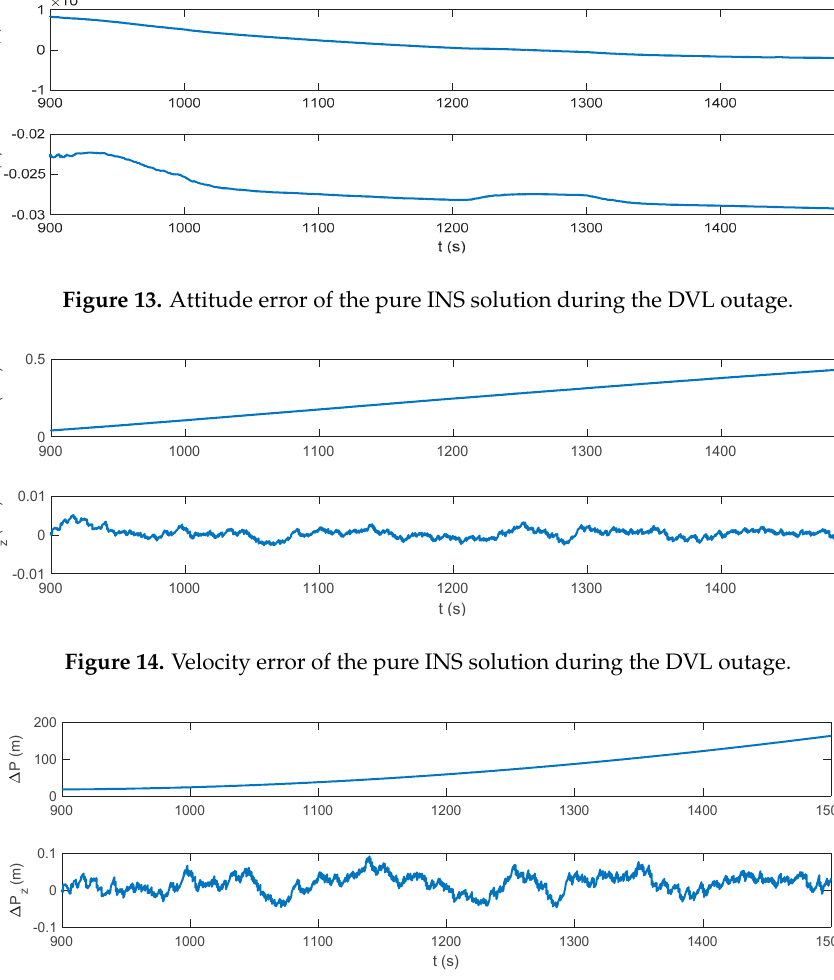
Figure 15. Position error of the pure INS solution during the DVL outage.